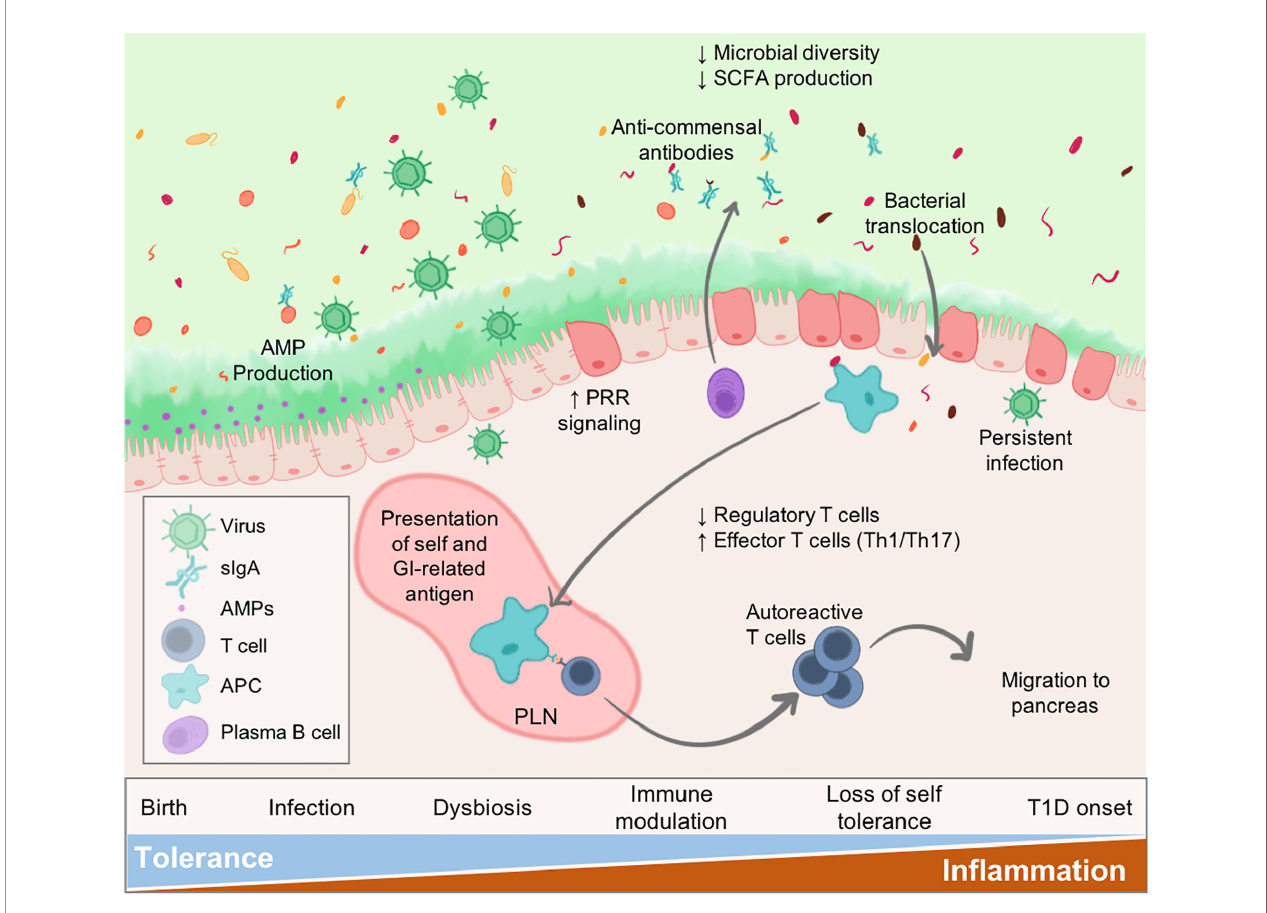
FIGURE 1 | Virus infections alter intestinal homeostasis to contribute to T1D. The GI environment is tightly regulated by numerous mechanisms. Perturbations such as virus infection results in dysbiosis and disruption to the enteric environment. Microbial dysbiosis is characterized by loss of species diversity and production of SCFAs including butyrate and acetate. As a result of dysbiosis and in fl ammation, the epithelial barrier becomes more permeable due to loss of tight junctions between epithelial cells, alteration of secreted IgA (sIgA) antibodies, and diminished mucus production. Some persistent infections may be maintained contributing to sustained in fl ammatory signalling within the gut. Both pancreatic self-antigens and commensal microbial antigens are taken up by APCs and presented to T cells in the pLN causing loss of self-tolerance. These autoreactive T cells migrate to the pancreas to contribute to anti-islet responses and destruction of insulin-secreting beta cells. Individuals would progress to T1D once suf fi cient beta cell mass is lost resulting in loss of blood glucose